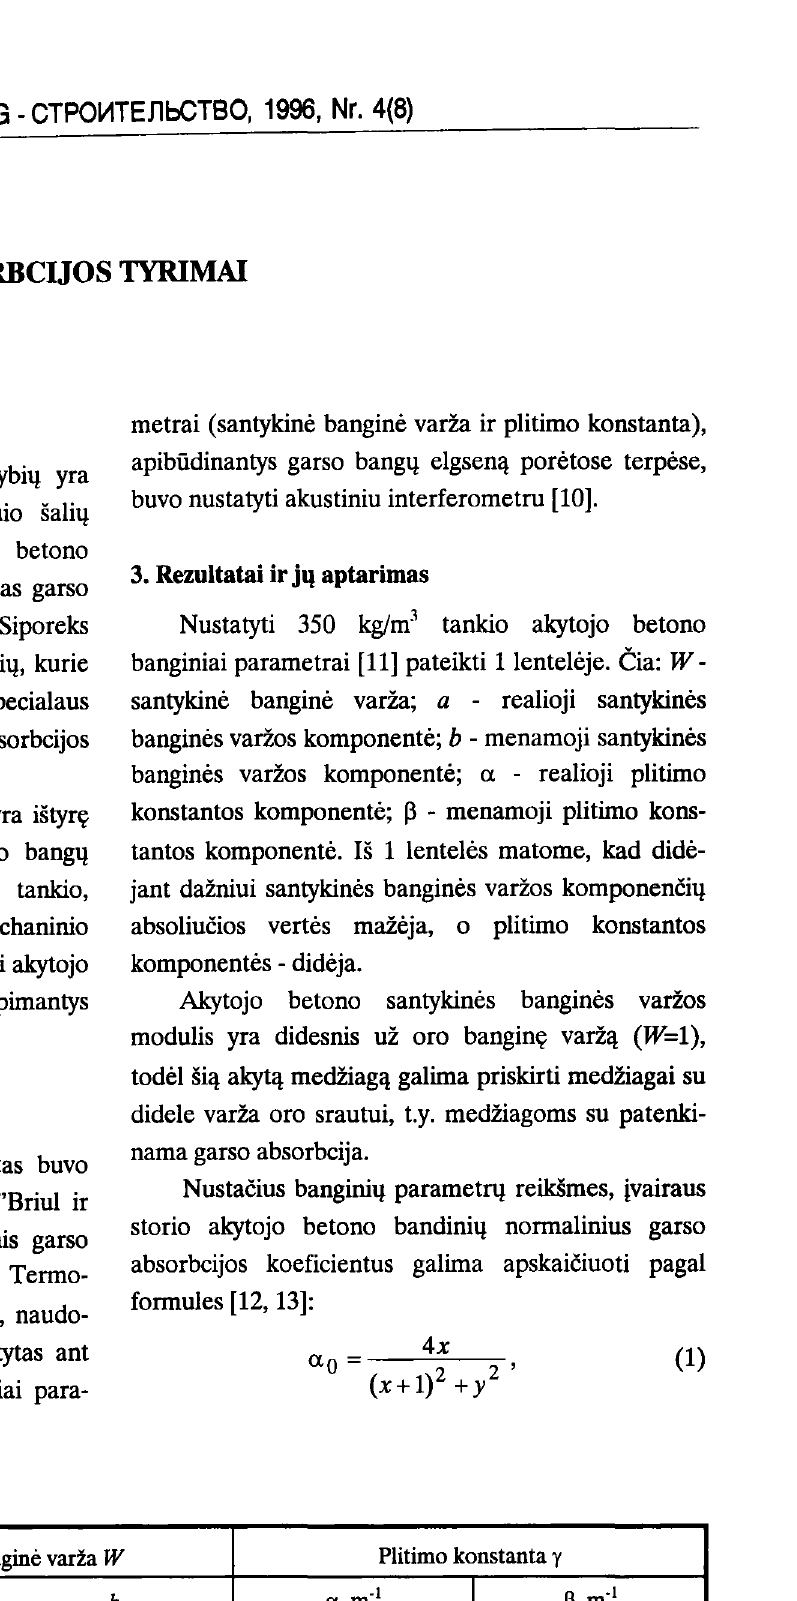
Table 1. Porous concrete wave